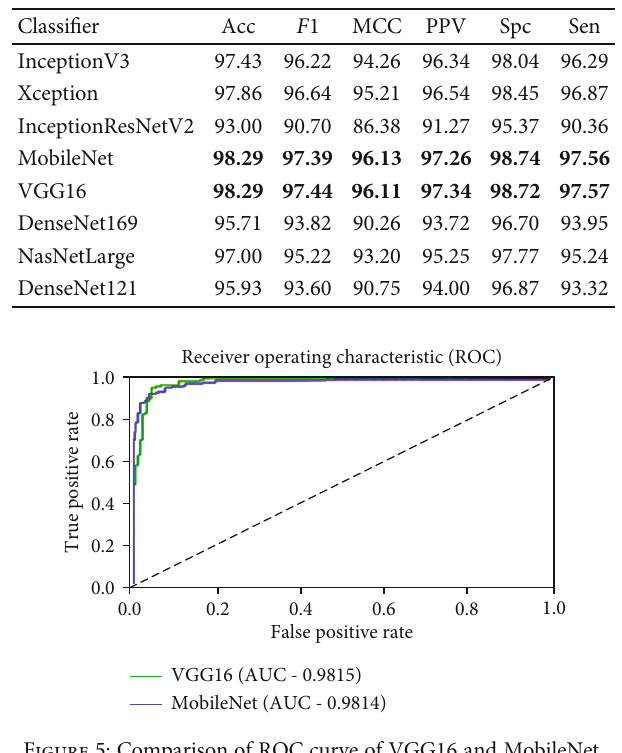
Figure 5: Comparison of ROC curve of VGG16 and